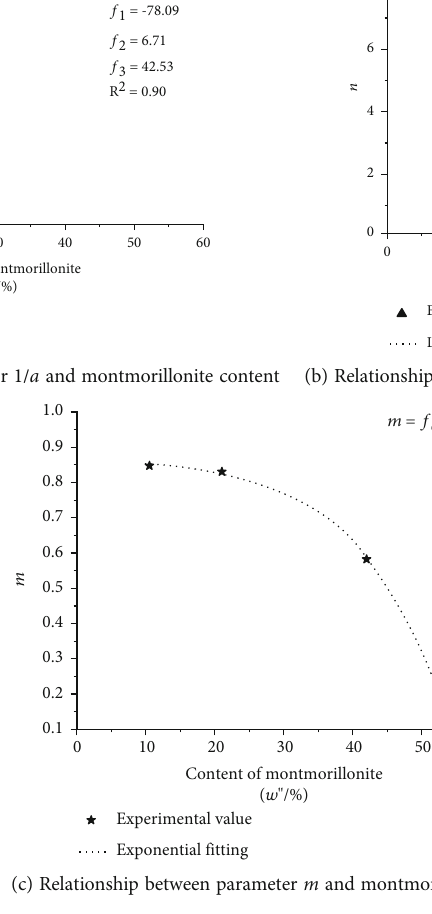
Figure 13: The relationship between van Genuchten model parameters and montmorillonite